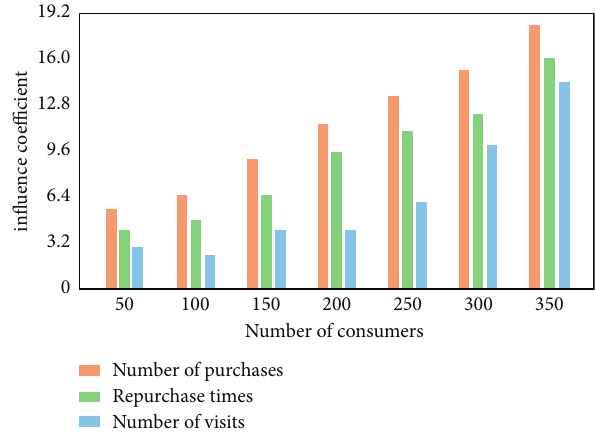
Figure 3: Influence coefficient of three aspects on brand visual